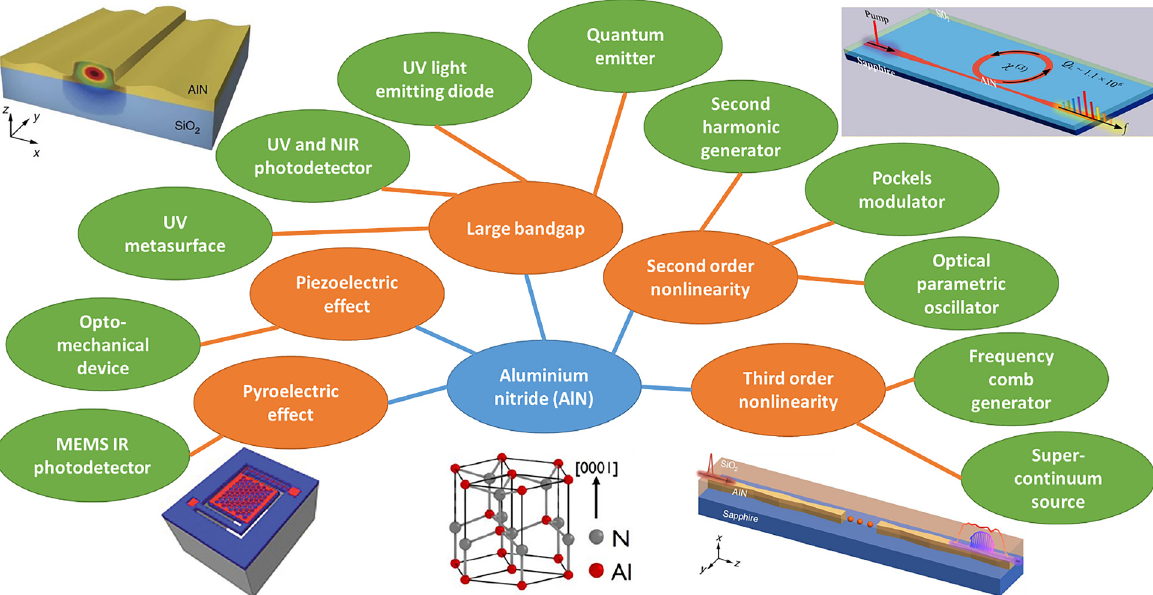
Figure 1: Overview of AlN-based integrated photonics. Blue, orange and green tags indicate material, key properties, and functional devices, respectively. Inset images: (Top left) Schematic of